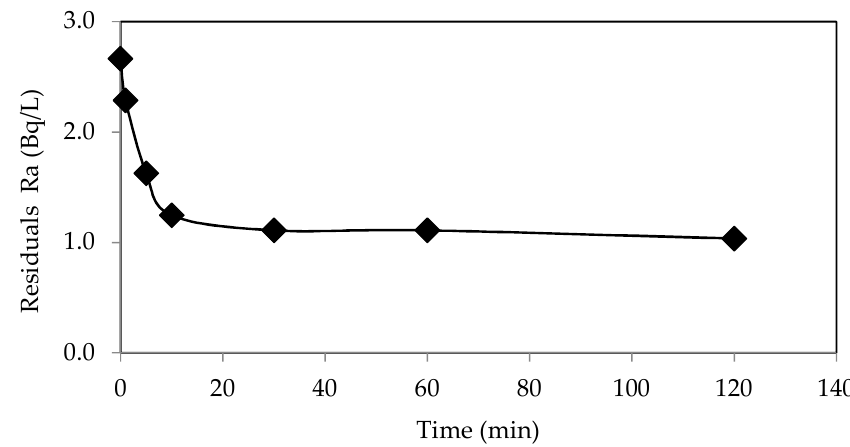
Figure 6. Removal of Ra by WTBS with time.